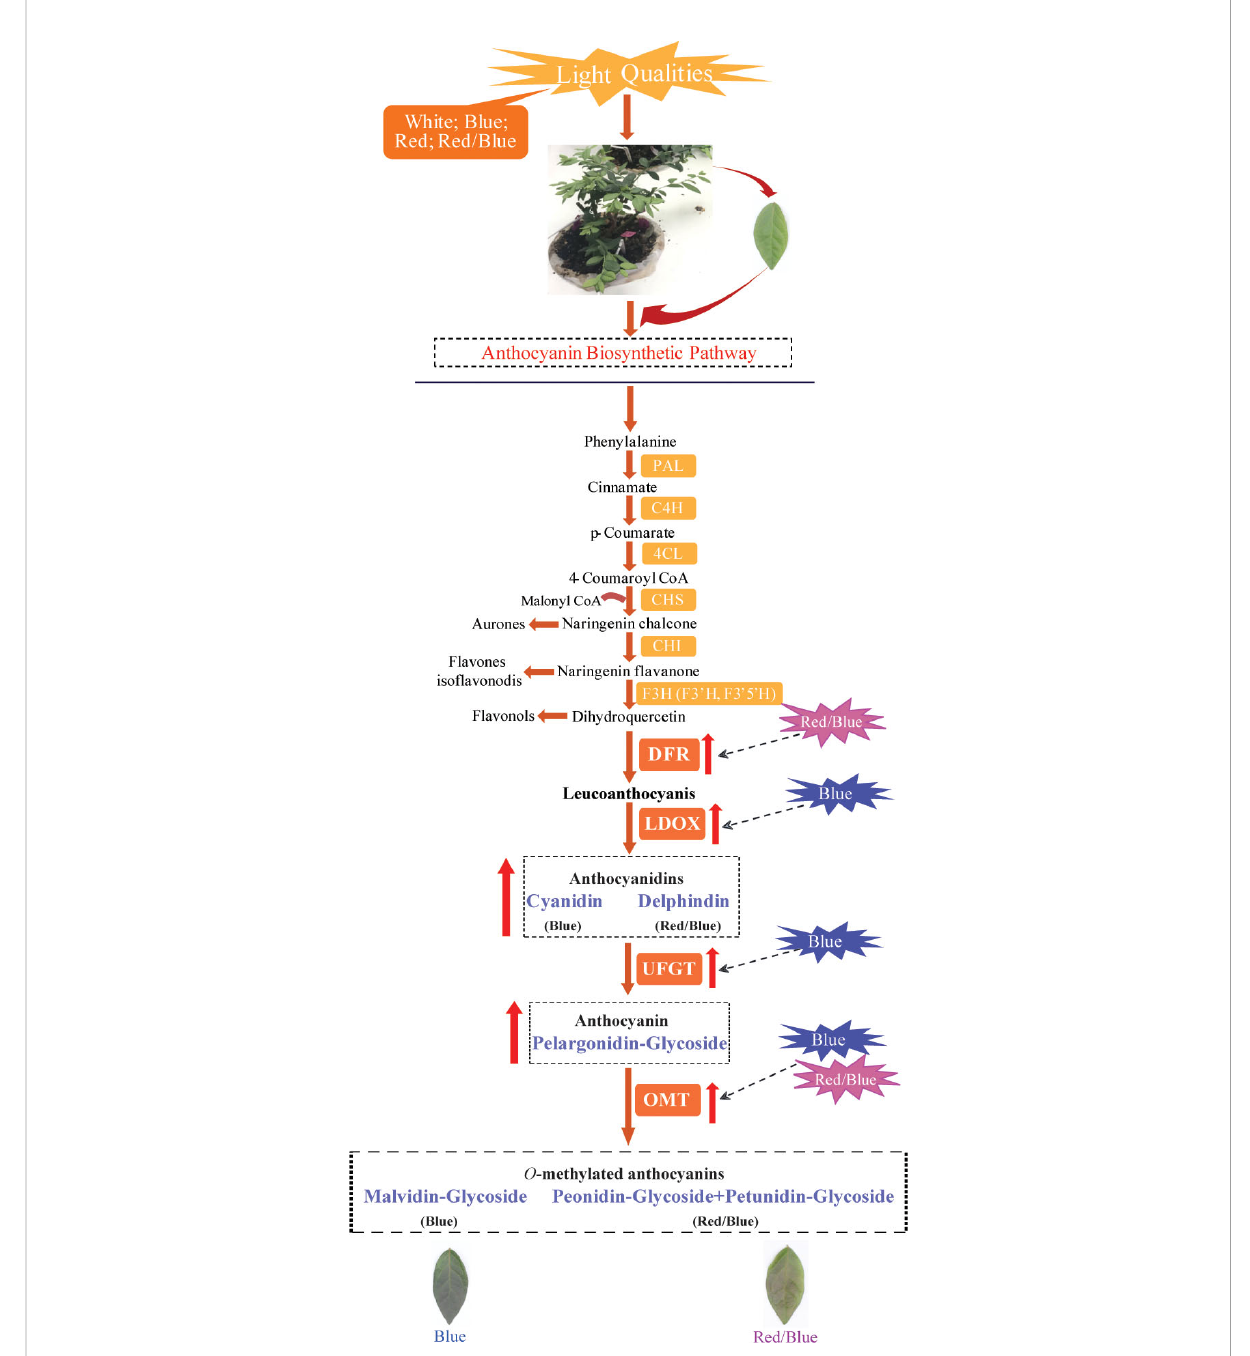
FIGURE 9 Proposed model of the molecular regulatory mechanism underlying anthocyanin biosynthesis in blueberry leaves in response to different light qualities. The red up-arrow indicates a signi fi cant increase; the dotted line arrow indicates a potential role for positive